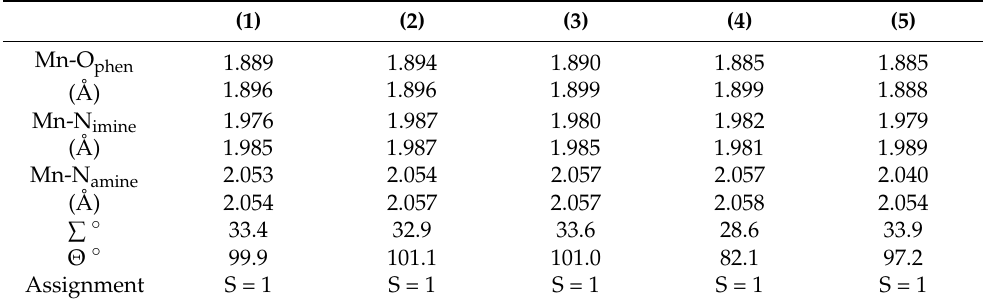
Table 3. Metal–ligand bond lengths and distortion angle parameters, ∑ (angular deviation at the origin) and Θ (trigonal torsion angle) for complexes 1 – 5 at 100